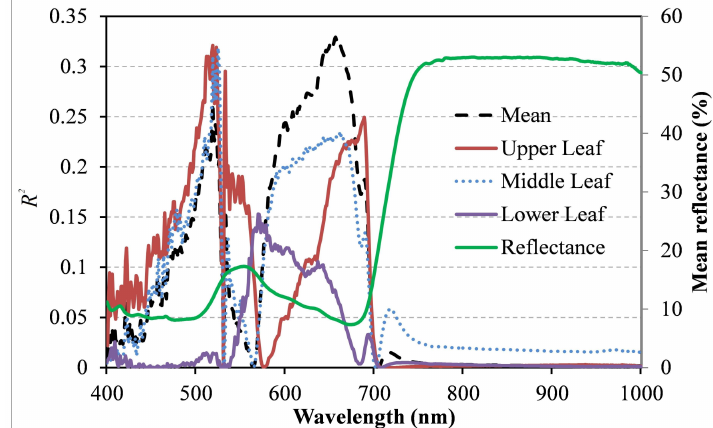
Figure 7. The relationship between fluorescence yield and PRI, calculated with varying reference bands in the range, 400–1000 nm. For all the leaf positions (upper, middle, lower and average leaf spectra), the relationship is strong when the reflectance of 519 nm wavelengths are used to formulate